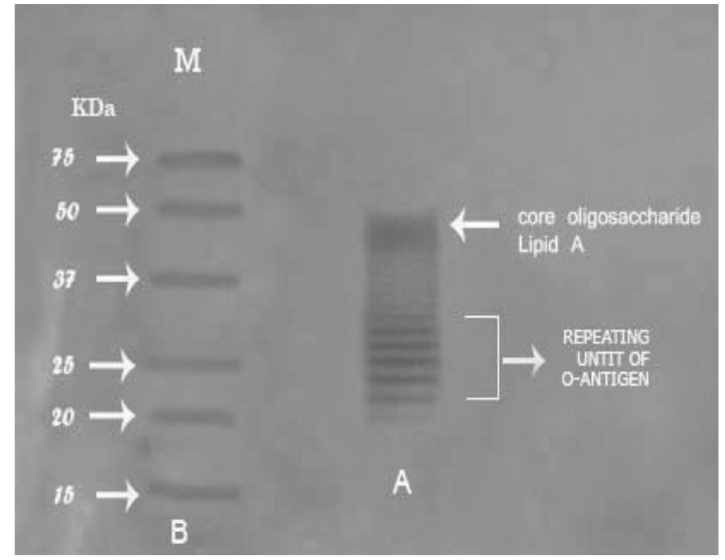
Fig. 4. SDS-PAGE profile of the purified endotoxin from P. aeruginosa ATCC 9027 lane A : ladder pattern of purified endotoxin. Lane B : protein marker ranged from 18-75